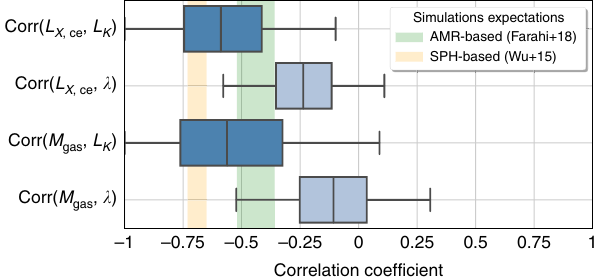
Fig. 1 Correlation coef fi cients of pairs of hot gas and galactic properties at fi xed weak-lensing mass. Empirical results from the LoCuSS cluster sample are shown as box plots, and the background bands show stellar mass and hot gas mass correlation coef fi cients from two independent hydrodynamical simulations, the Adaptive Mesh Re fi nement (AMR)-based Rhapsody-G 10 and the Smoothed Particle Hydrodynamics (SPH)-based BAHAMAS + MACSIS simulations 11 . In the box plot representation, the middle line shows the median of the posterior distribution while box edges show the fi rst and third quartiles (25th and 75th percentiles, respectively) with whiskers extending to show the inner 95% of the posterior distribution (2.5 – 97.5%). The shaded regions are 68% con fi dence intervals